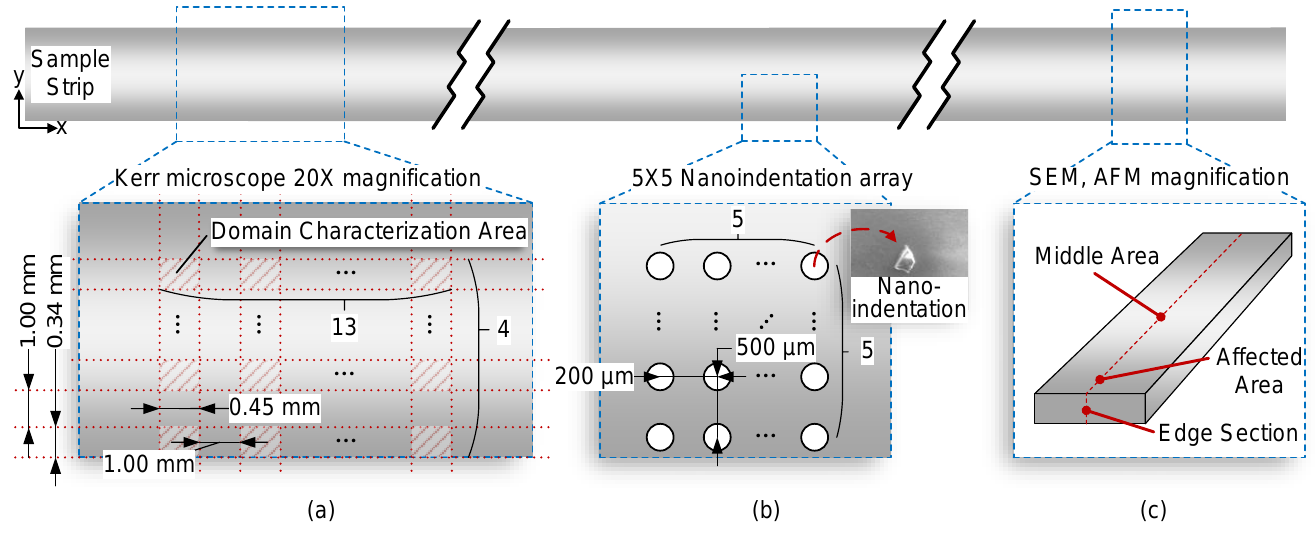
Figure 3. Micro characterization scheme. ( a ) Observation scheme for the magneto-optical Kerr microscope. ( b ) Nano-indentation characterization scheme. ( c ) Micro characterization